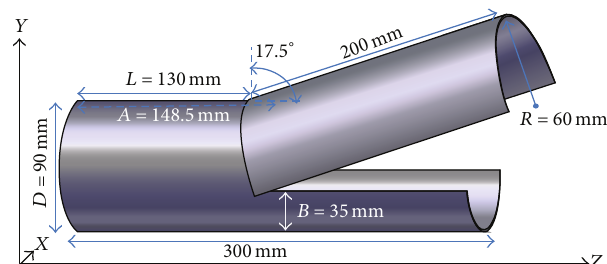
Figure 13: Step-cut Vlasov antenna with a reflector.